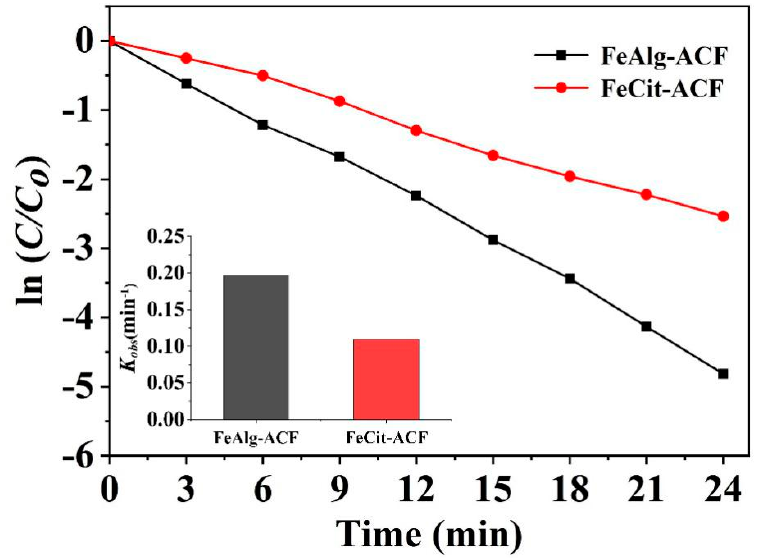
Figure 4. Time profiles of azophloxine decolorization in FeAlg-ACFs/PMS/visible light and FeCit-ACFs/PMS/visible light; the inset shows the k obs values of the corresponding systems. Reaction conditions: [PMS] = 5 mmol/L, T = 25 °C, pH = 6. Other chemical reagents used: [FeAlg-ACF] = 2 g/L, [FeCit-ACF] = 2 g/L, [azophloxine] = 50 μ mol/L.